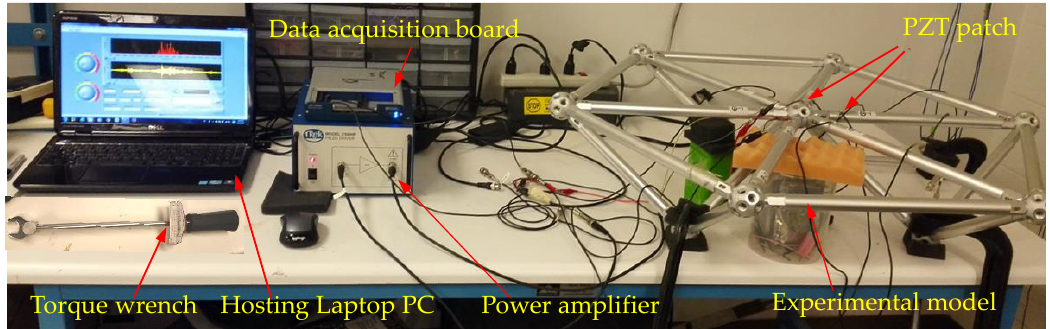
Figure 6. Experimental setup.